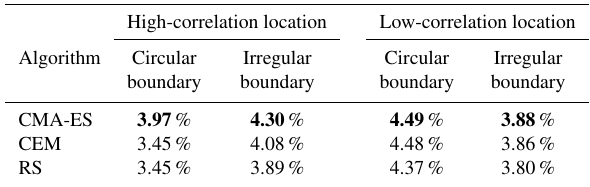
Table 3. Mean performance gains over the baseline site for 10 runs of each optimization